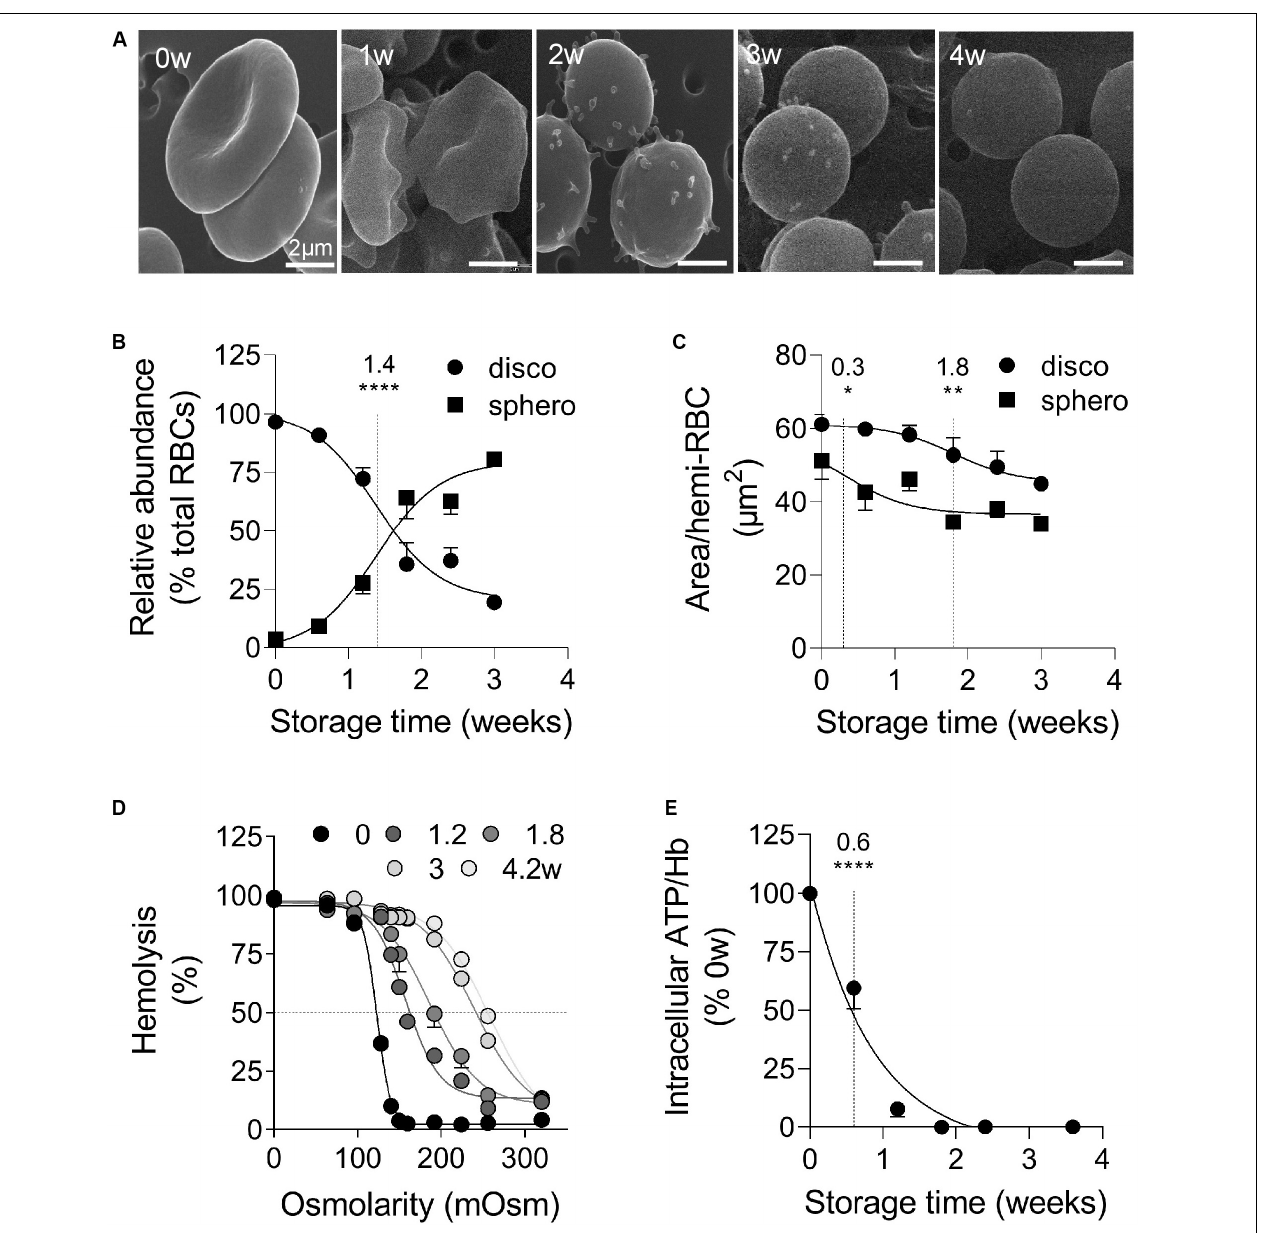
FIGURE 1 | During storage in K + /EDTA tubes at 4 ◦ C, RBCs rapidly lose biconcavity and energy, become more fragile and form surface vesicles. RBCs stored for 0 to 4 weeks (w) in K + /EDTA tubes at 4 ◦ C were isolated and analyzed for morphology (A,B) , size (C) , fragility (D) , and intracellular ATP content (E) . The time needed to reach 50% effect and the corresponding statistical analysis (Mann–Whitney U test) are indicated above the vertical dotted line. (A) Scanning electron microscopy images of RBCs on filters. RBCs were fixed in increasingly concentrated glutaraldehyde solutions, deposited on filters, post-fixed with osmium tetroxide, covered with gold and observed by electron microscopy. Representative images of 1 experiment including 3 preparations per storage time. (B,C) Abundance and surface area of spherocytes vs. discocytes. RBCs were immobilized on poly- L -lysine (PLL)-coated coverslips, imaged and classified into two categories, the discocytes (disco; circles) and the spherocytes (sphero; squares), which are smaller and possess higher circularity. In (B) , data are means ± SEM of 7 independent experiments where at least 100 RBCs were analyzed. In (C) , data are means ± SEM of 4 independent experiments where at least 150 RBCs were analyzed. (D) RBC osmotic fragility. RBCs were incubated at RT in media of decreasing osmolarity. After centrifugation, the hemoglobin (Hb) content in the supernatant and in the pellet were measured by spectrophotometry at 450 nm. The horizontal dotted line indicates the medium osmolarity at which 50% of the RBCs were lysed. Data are means ± SD of 1 experiment representative of 2. (E) Intracellular ATP content. RBCs were lysed and incubated with firefly luciferase and luciferin. The intensity of the light emitted following the oxidation of luciferin to oxyluciferin by luciferase in the presence of ATP was then measured by luminescence. The intracellular ATP concentration was normalized on the Hb content and then expressed in % of fresh RBCs (i.e., 0 weeks of storage). Data are means ± SEM of 4 independent experiments. * p < 0.05; ** p < 0.01; **** p < 0.0001.